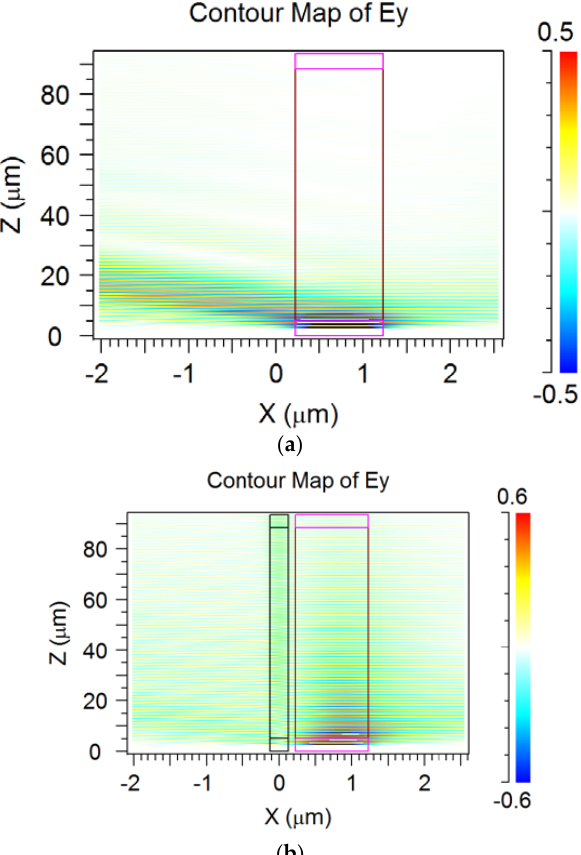
Figure 12. Counter plot of electric field Ey for the Gaussian optical beam launched into polymer strip connected with segmented grating. ( a ) Without silicon waveguide; ( b ) with silicon waveguide on a distance d from the grating. M = 128, W = 1.0 µm, h = 0.25 µm, w = 0.45 µm, d = 0.1 µm. Simulation made by 2D FDTD. Asymmetric radiation to the environment due to SiO 2 on the left and water on the right from the grating structure.